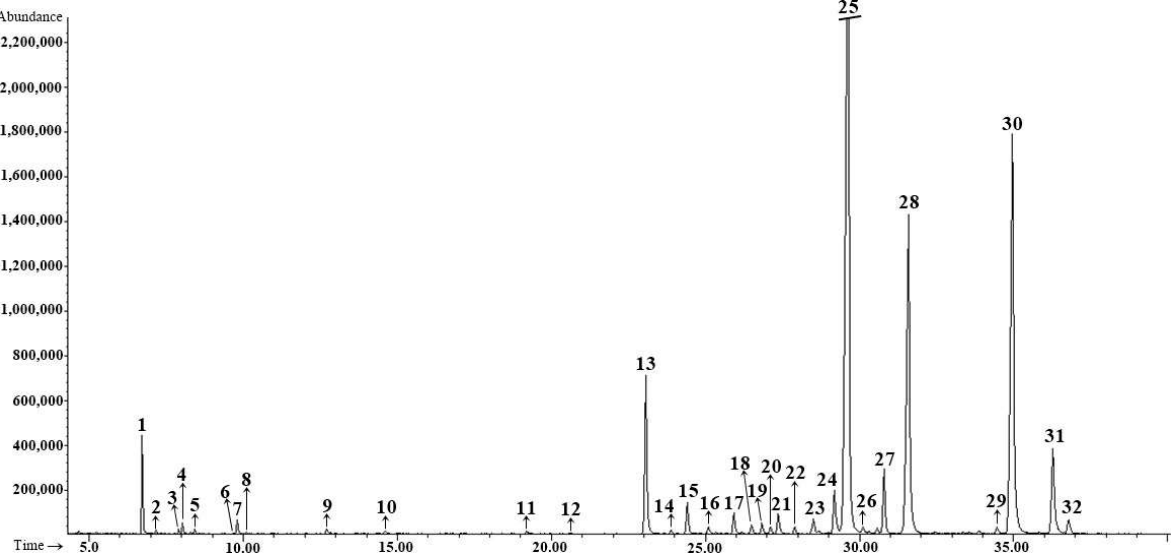
Figure 2. Chromatogram (GC/FID) of wild carrot essential oil from fully ripening umbels.